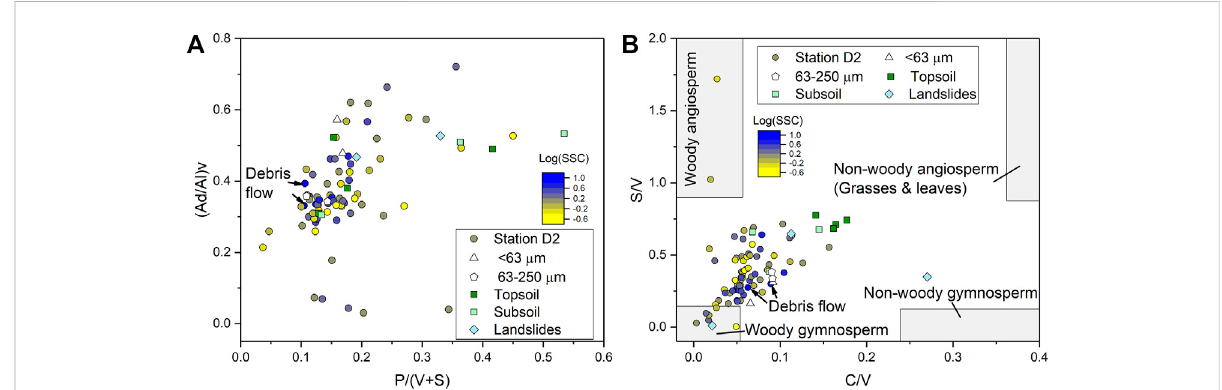
FIGURE 4 The source of the terrestrial organic carbon as shown by (A) P/(V+S) and (Ad/Al)v; (B) C/V and S/V at the station D2, the Zagunao River. The colorsofbubblesrepresentthesuspendedsedimentconcentration(SSC).TherangesofS/VandC/Vfordifferentvegetation(squares)arefromGoñi and Hedges (1995).